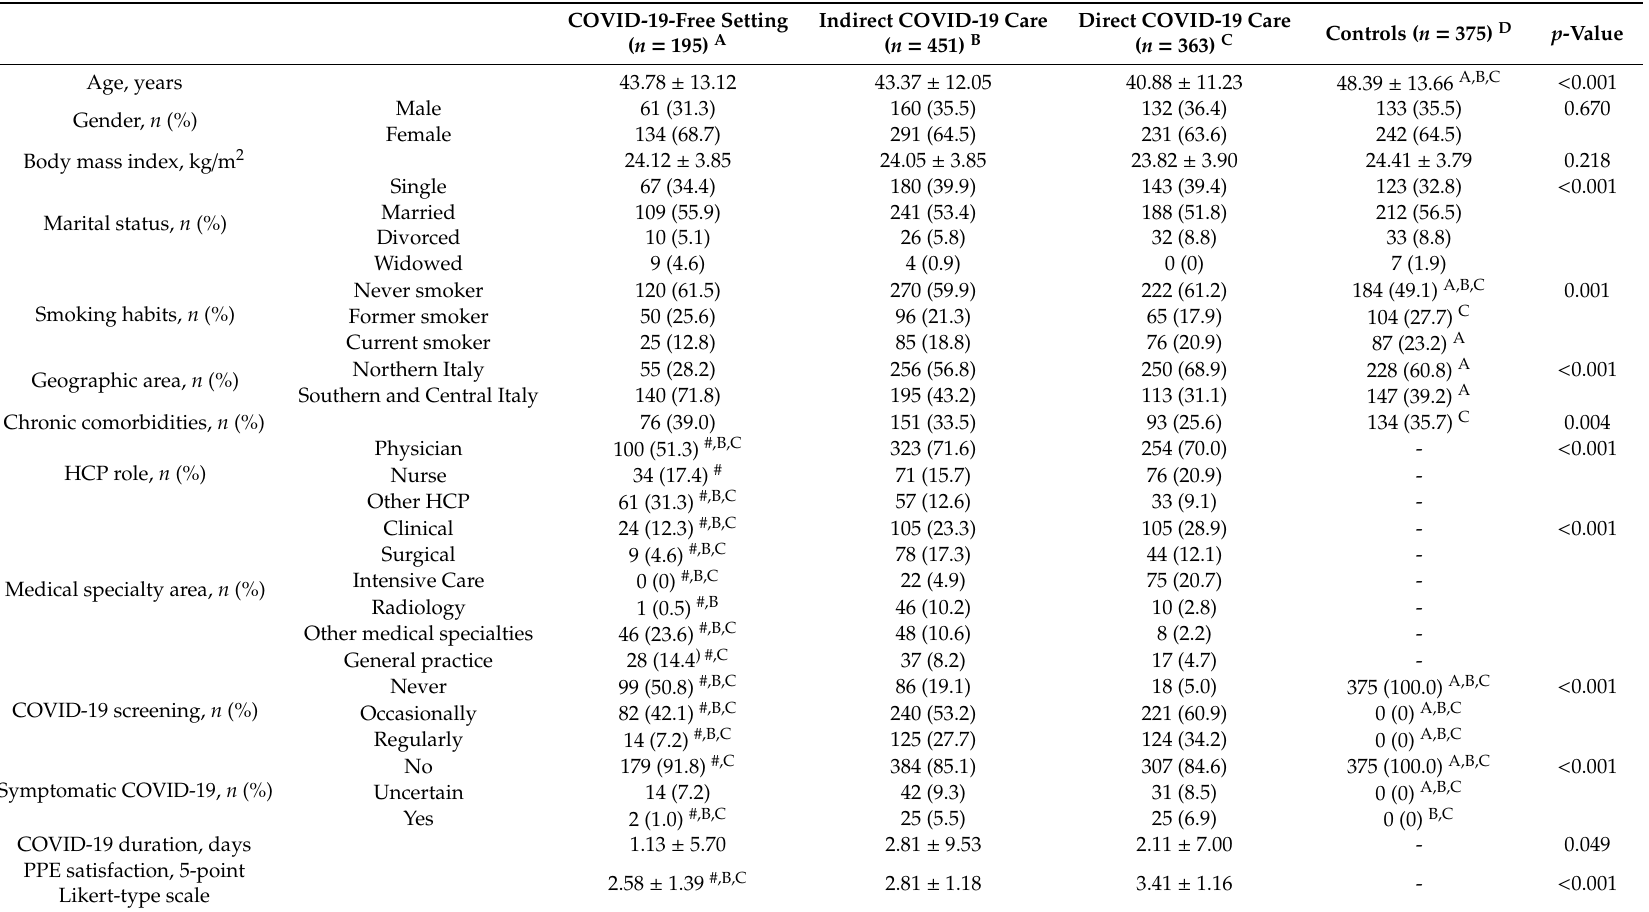
Table 1. General characteristics of the study